Question: What form of chart is displayed?
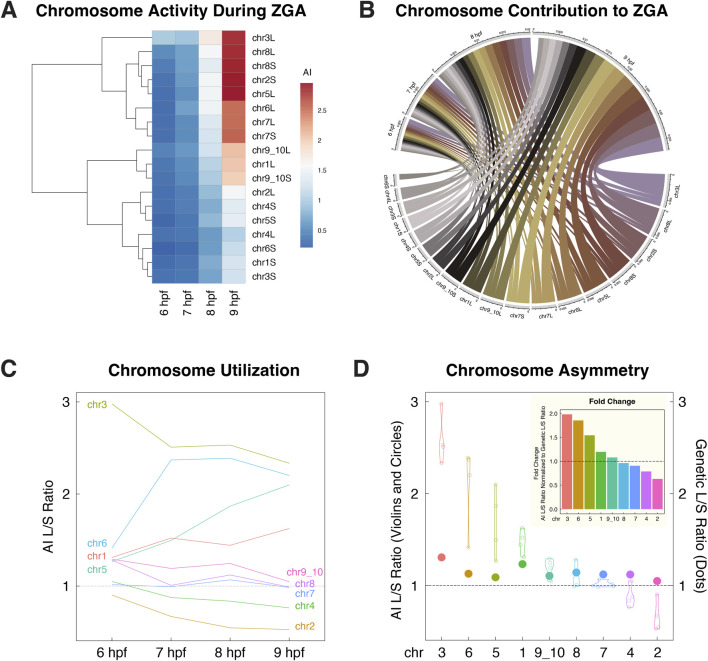
Answer: heatmap